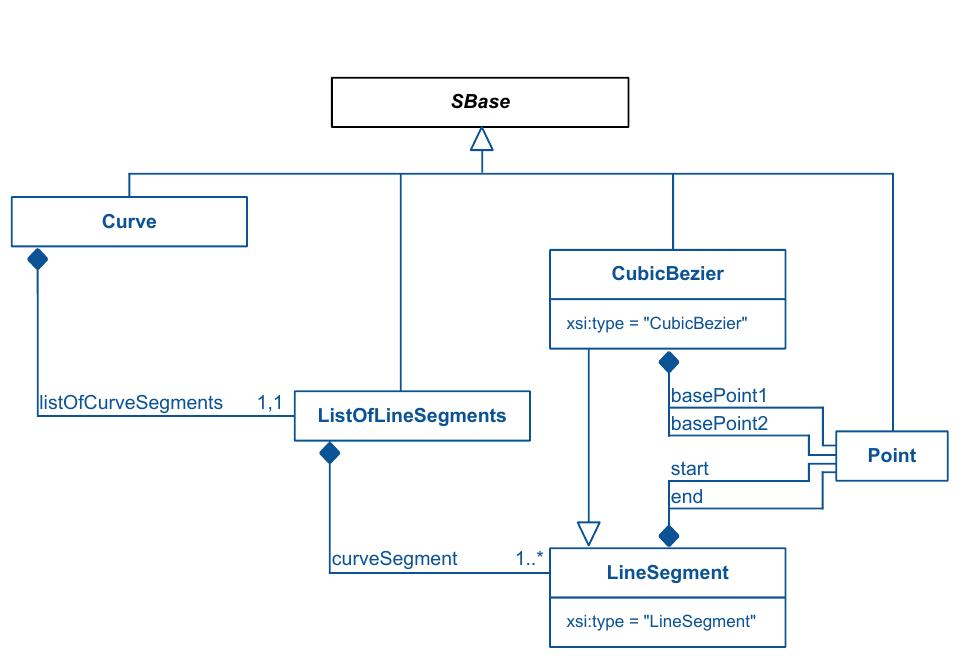
Figure 5: The definitions of the Curve class.